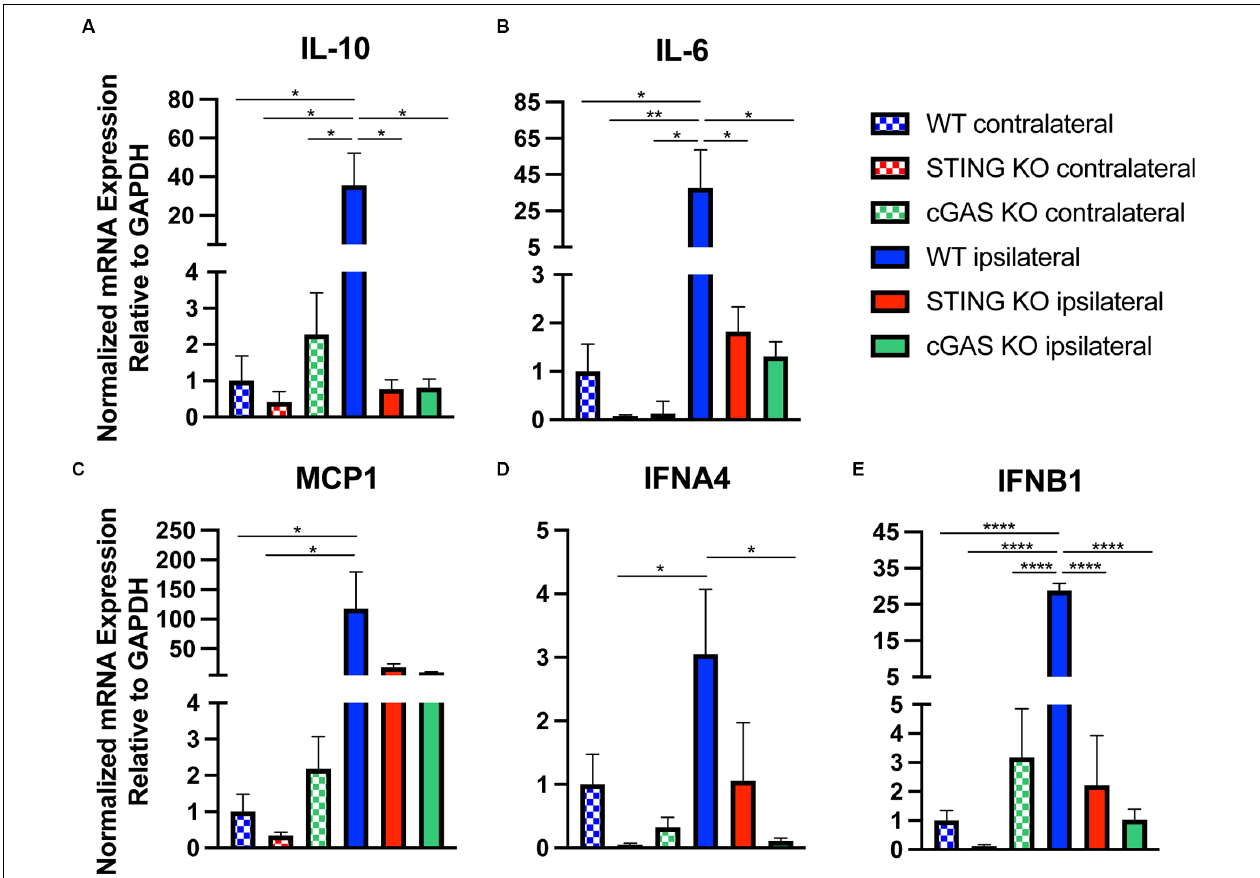
FIGURE 4 | Loss of cGAS-STING blunts the innate immune response to TBI. Quantified mRNA expression of (A) Il10 , (B) Il6 , (C) MCP1 , (D) IFNA4 , and (E) IFNB1 assessed by qPCR at 24 h post-injury in wildtype, STING − / − , and cGAS − / − cortices. Gene expression normalized to GAPDH. n = 5–6 per group. Data presented as mean ± SEM. * p < 0.05, ** p < 0.01, **** p <